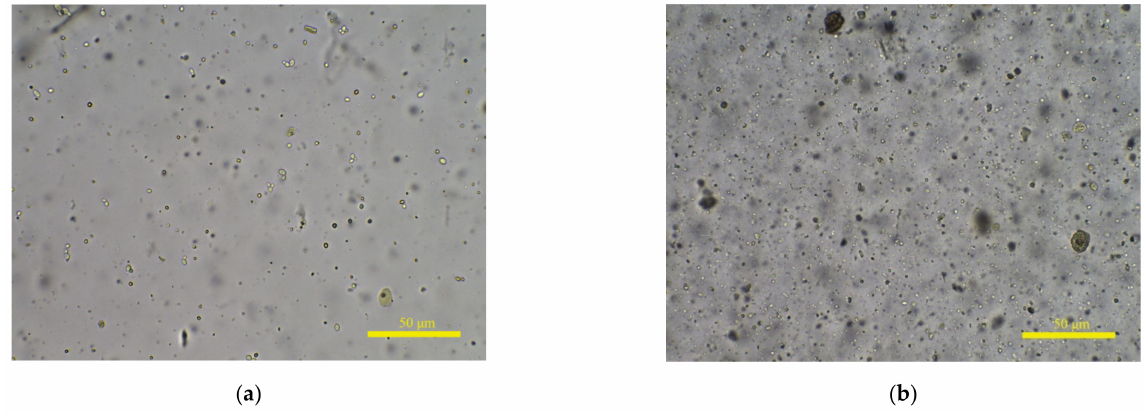
Figure 1. Complex image composition of fecal microscopic images. ( a , b ) are clear microscopic images from different feces sample solutions with low and high concentrations,